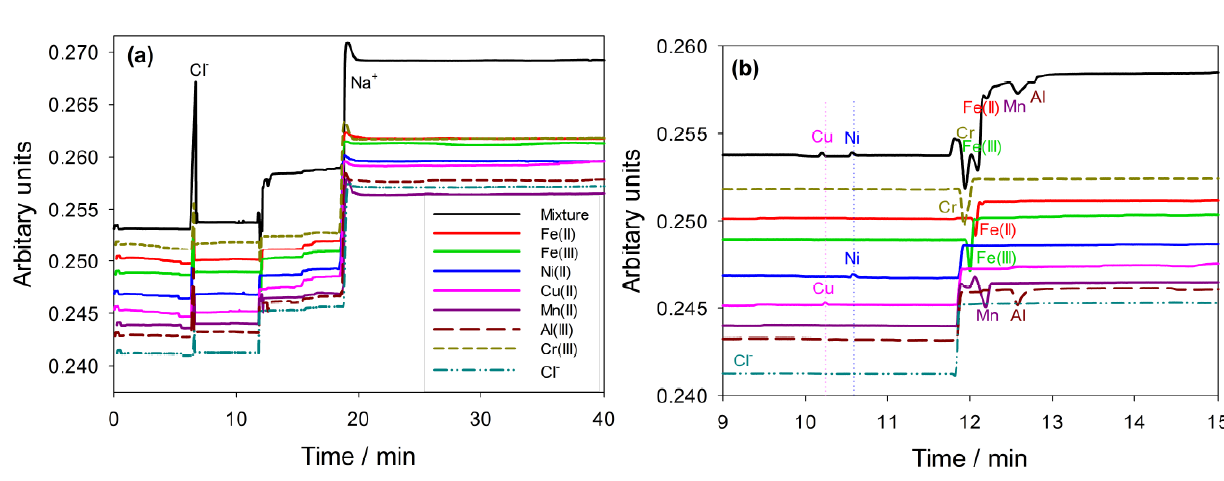
Figure 3. Electropherograms showing separation of seven individual metal ions and chloride ion at the 10 ppm level and when in a mixture, under the optimised conditions described in the text.